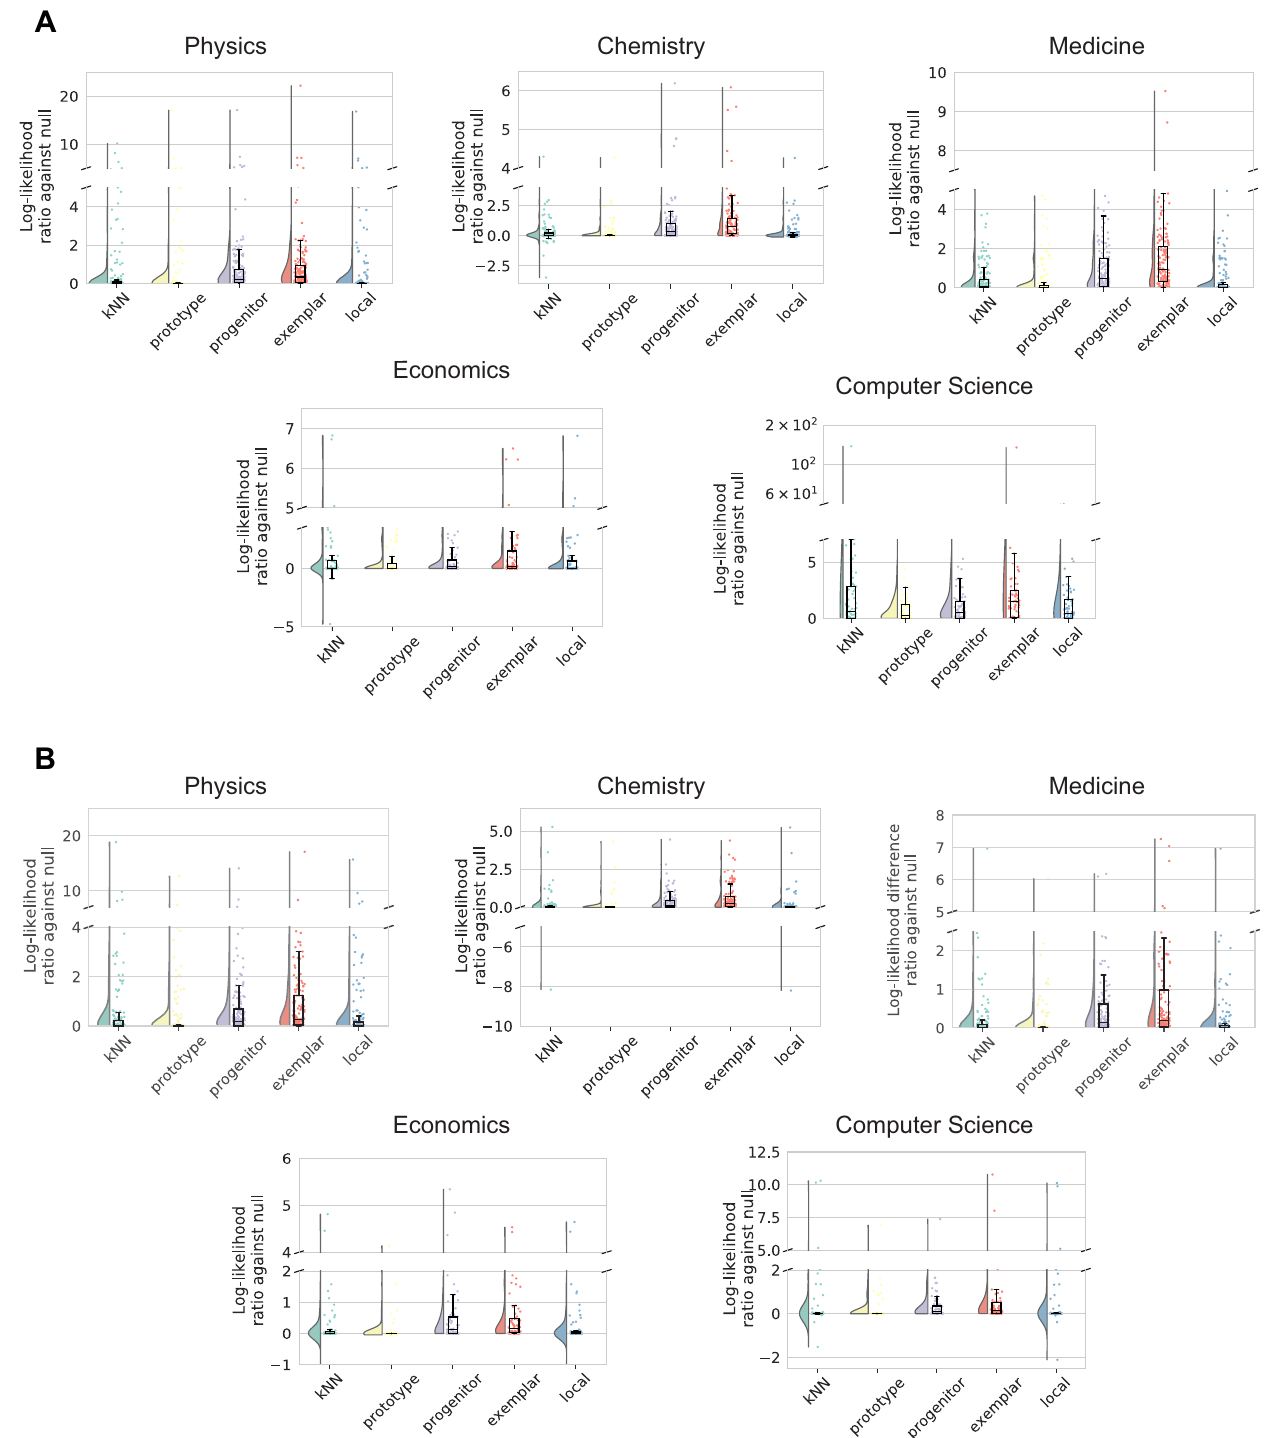
Fig 2. Summary of model predictive performance. (A) Log-likelihood ratio of model against the null random baseline model based on predicting historical data from the prominent scientists across the 5 fields. 0 on the vertical axis indicates equal performance between a chaining model and the null model; values above 0 indicate superior performance over the null model. (B) Similar information for the random-sampled